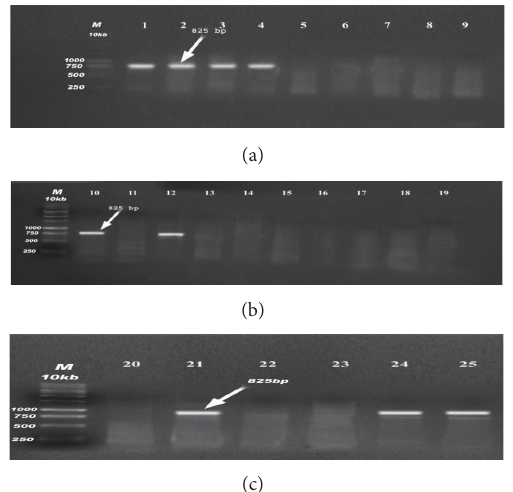
Figure 1: (a, b, c) Detection of tsh gene in samples. Positive samples produce band (825 bp); lane M: 1Kb DNA Ladder; lanes 1, 2, 3, 4, 10, 12. 21, 24, and 25 were positive samples.